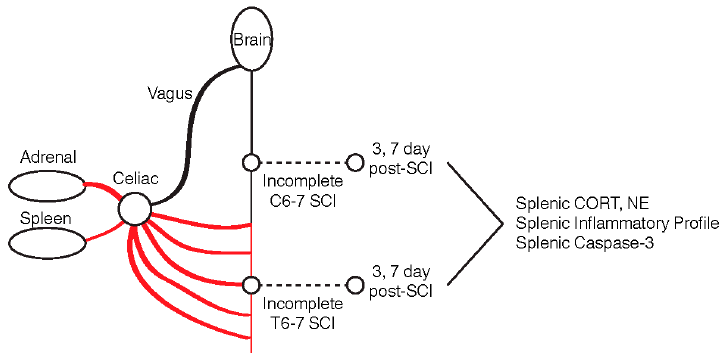
Figure 1. Experimental design. Two moderate-severe spinal cord injury (SCIs) were induced at cervical (C6–7) and thoracic (T6–7) levels and splenic cortisol (CORT), norepinephrine (NE), and inflammatory profile were assessed 3- and 7-days post-SCI.